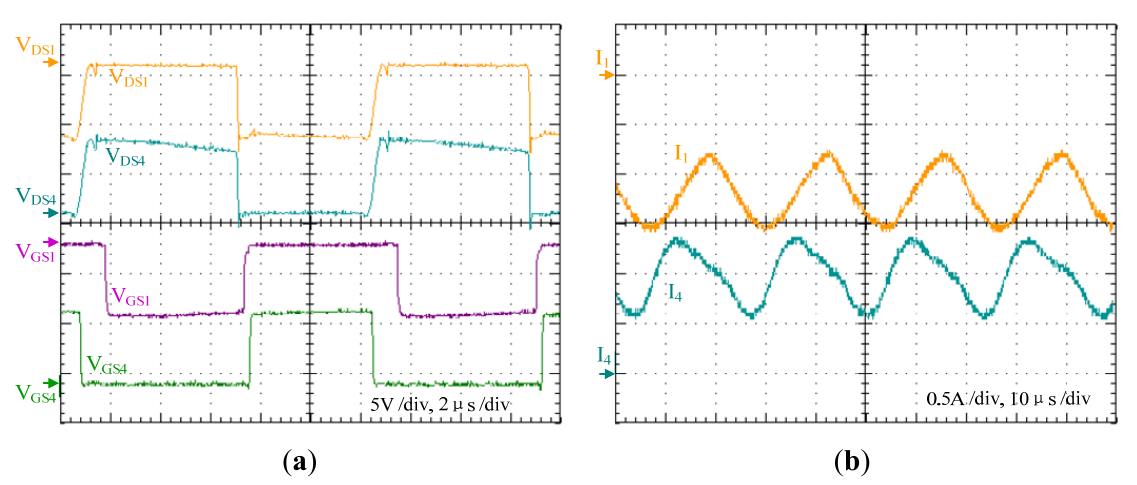
Figure 8. The waveforms of the designed circuit for the proposed balancing topology: ( a ) The GSV and DSV of the MOSFETS. ( b ) The balancing currents of the two cells.